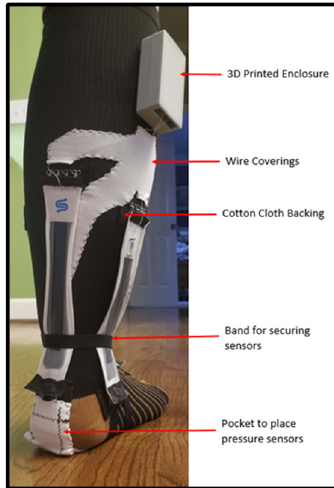
Figure 11. Hook and eye attachment to hold SRS in place.